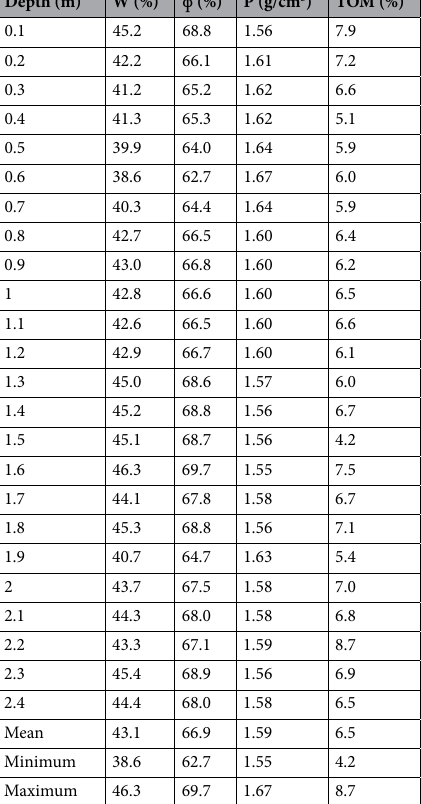
Table 1. Physical–chemical parameter distribution in marine sediments.